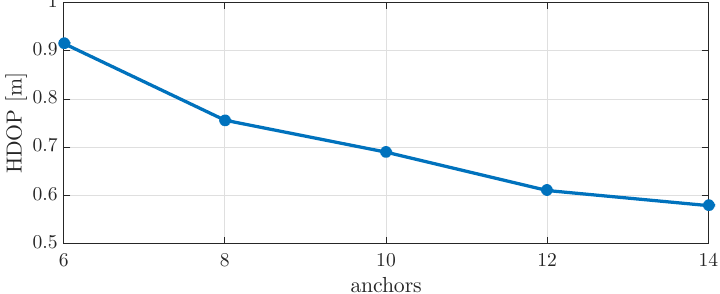
Figure 8. Horizontal dilution of precision (HDOP) as function of the number of anchors N